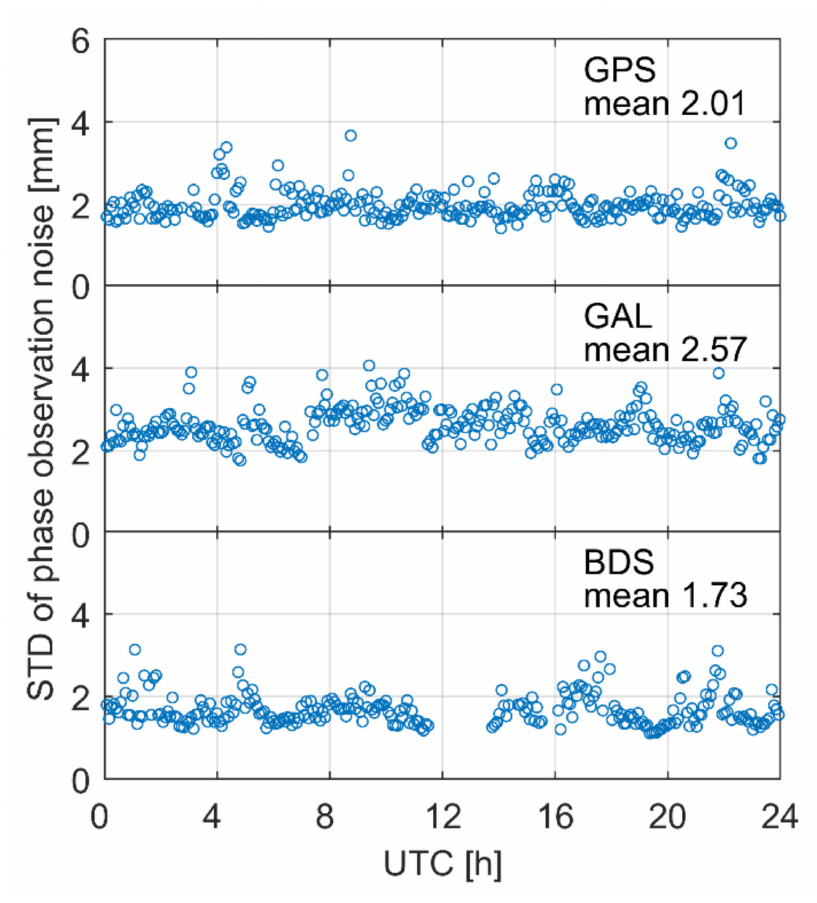
Figure 6. Estimated STD of the GPS, Galileo, and BDS SD phase observation noise calculated using the IGG1–IGG2 baseline data collected on DOY 268,